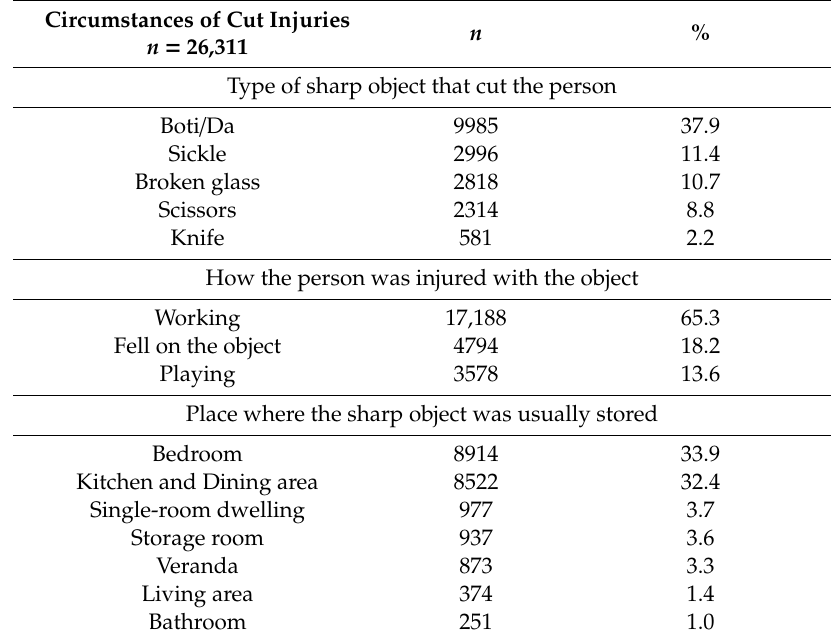
Table 3. Circumstances of cut